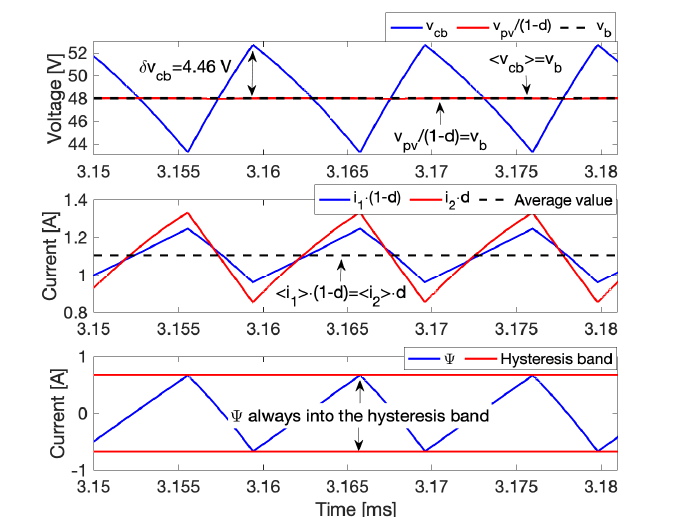
Figure 16. Stable operation of the proposed PV